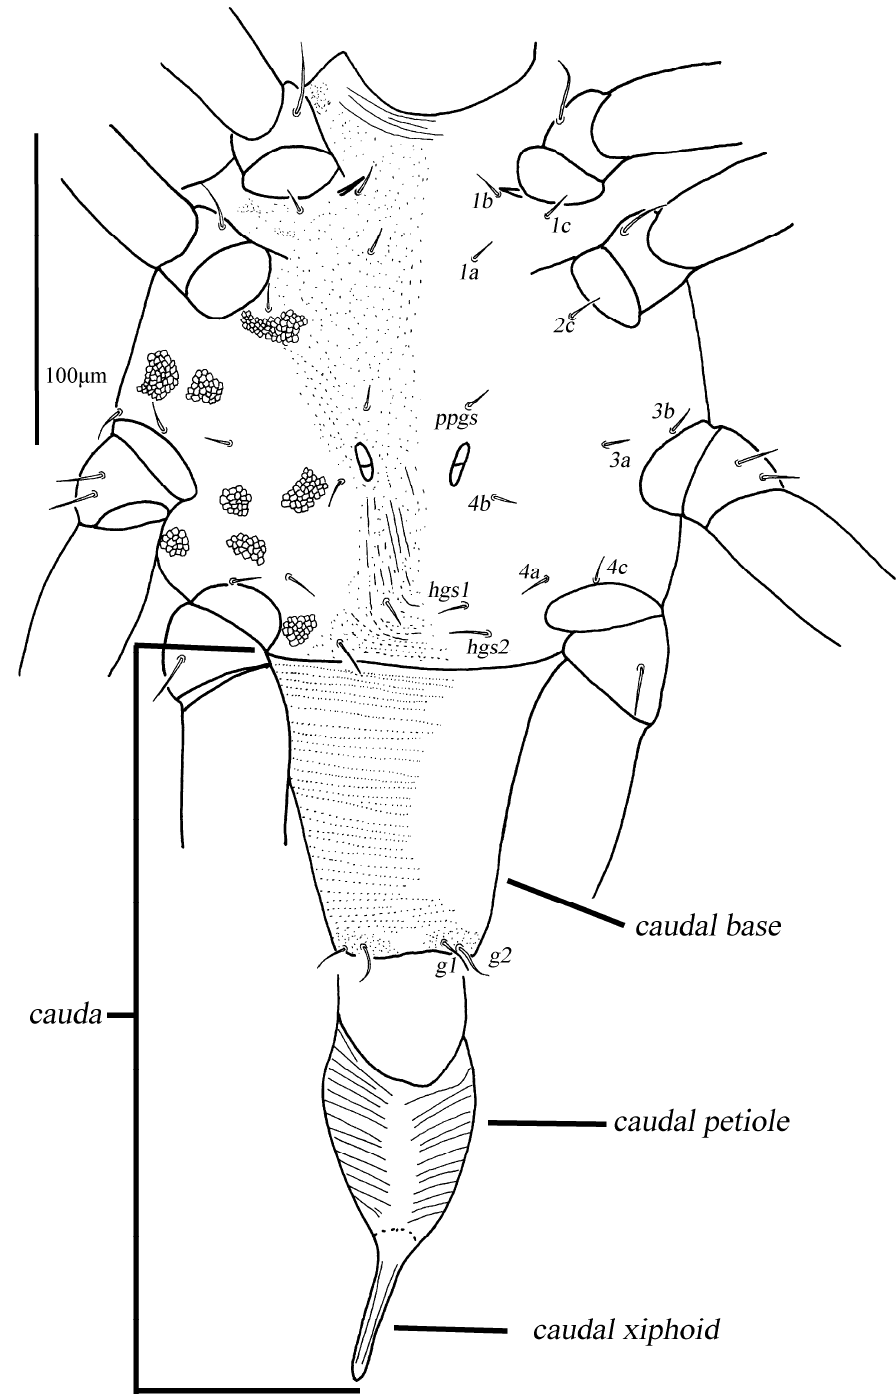
Figure 10. Cunaxicaudus neomohanensis sp. nov . (male). Ventral idiosoma. Scale bar = 100 µm.